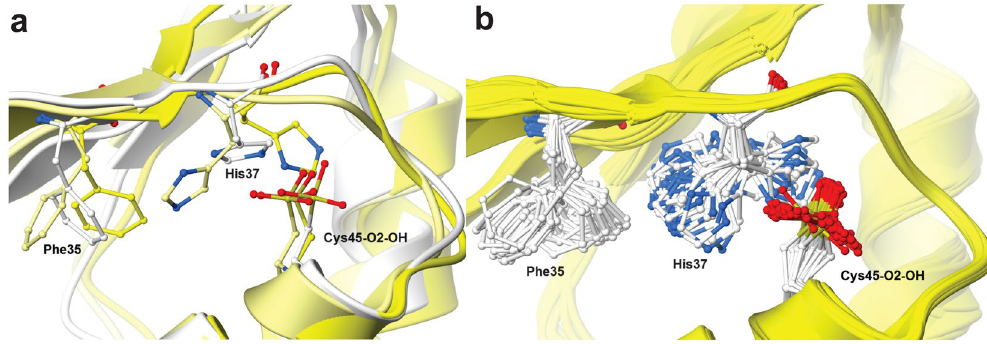
Figure 3. Visualisation of the dynamic movement of Phe35 and His37. ( a ) The active site of monomer B at three different time points along the MD trajectory (t = 1 ns, white, 20 ns, light yellow and 75 ns, yellow) visualizes the coordinated motion of Phe35 and His37. The His37 side chain dihedral angle of about − 180° corresponds to the conformation found in monomer A and the value of − 57° to that found in monomer D. The active site C P (Cys45-O 2 -OH) does not move significantly. ( b ) Active site of monomer B after Ensemble Refinement. The final Ensemble contained 45 models of the AnPrx6 structure. While Phe35 and His37 display multiple alternative orientations, the orientation of the oxidized C P does not vary significantly. Although the MD simulations and the Ensemble refinement are independent methods, they both suggest large conformational oscillations for His37 and Phe35 in monomer